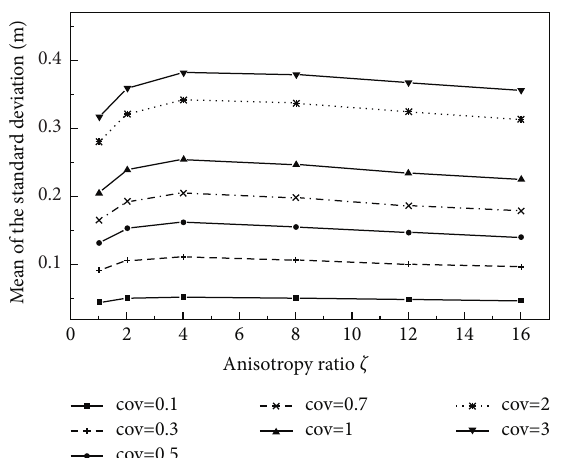
Figure 9: Mean of the total head standard deviation versus an- isotropy ratio of hydraulic